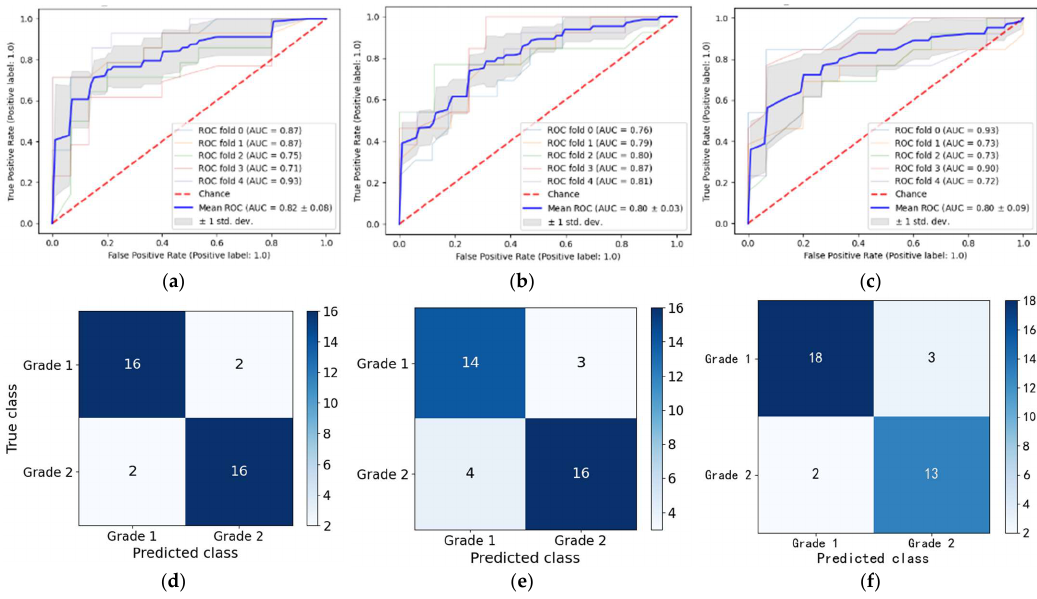
Figure 16. SE-DenseNet for three coniferous wood’s mechanical strength binary classification: ( a ) Cross-validation set ROC curve for larch; ( b ) Cross-validation set ROC curve for hemlock; ( c ) Cross- validation set ROC curve for mongolica; ( d ) Test set confusion matrix for larch; ( e ) Test set confusion matrix for hemlock; ( f ) Test set confusion matrix for